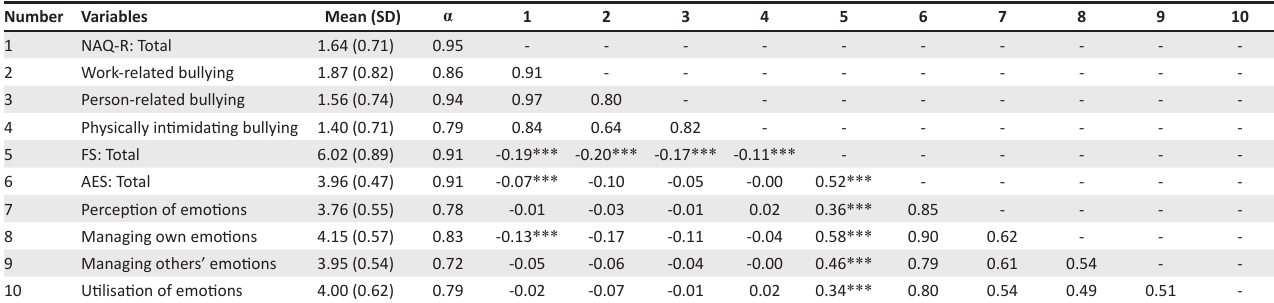
TABLE 2: Descriptive statistics: Means, standard deviations, internal consistency reliability coefficients and zero-order correlations ( N = 1102). Number Variables